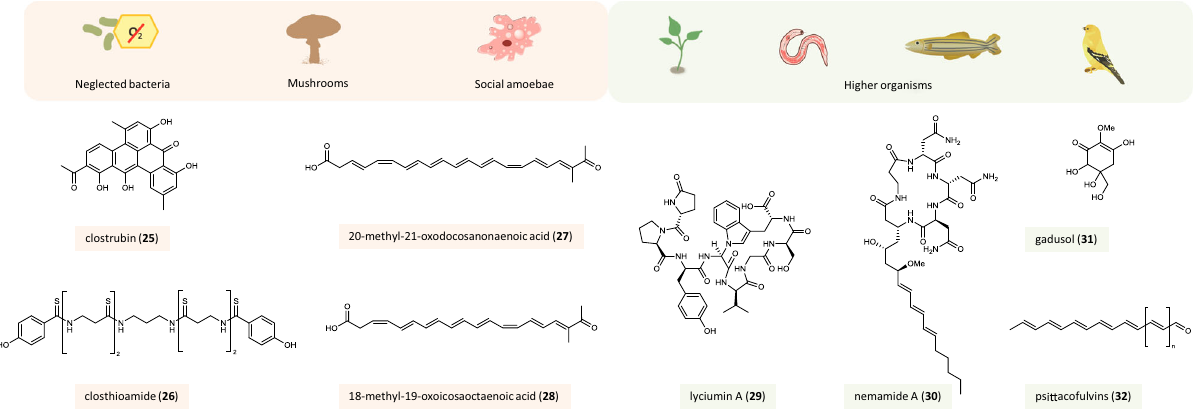
Fig. 4 Genome-guided discovery of natural products from unconventional sources. Neglected bacteria, mushrooms, social amoebae, and higher organisms as sources and examples of natural products discovered from these organisms. The color code of the boxes around the compound names and icons indicates the source of the respective compound: light orange — microbes (neglected bacteria, mushrooms, and amoebae), green — higher organisms (plants, nematodes, fi